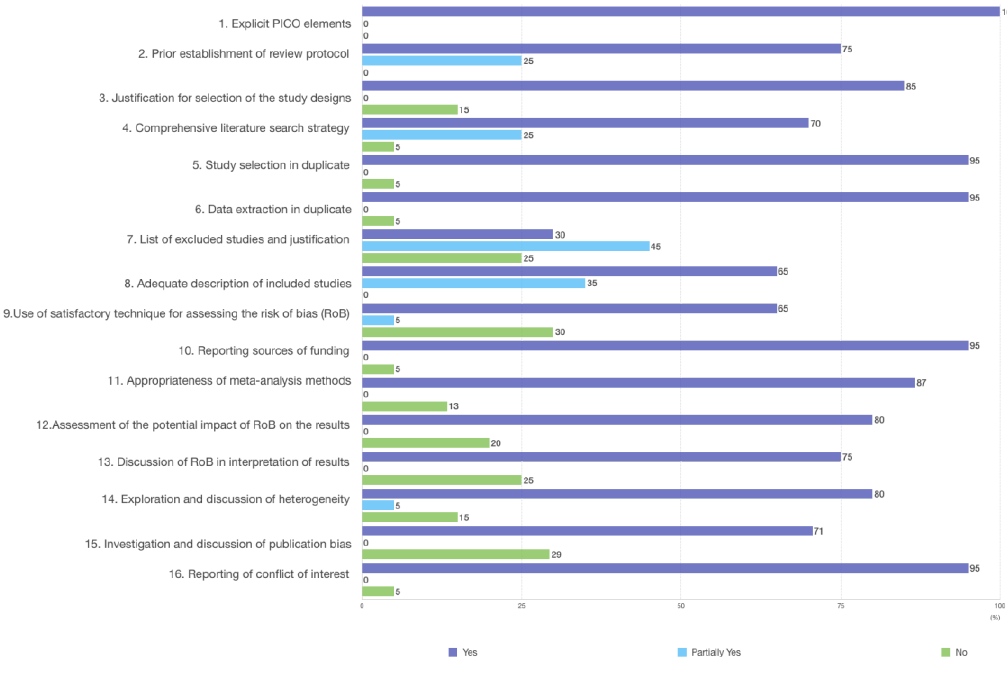
Figure 3. Quality assessment of articles included, by AMSTAR 2 critical domains. Table 3. Description of the articles included, by year of publication, country’s mention, target group, country’s specific findings, period of study and analysis